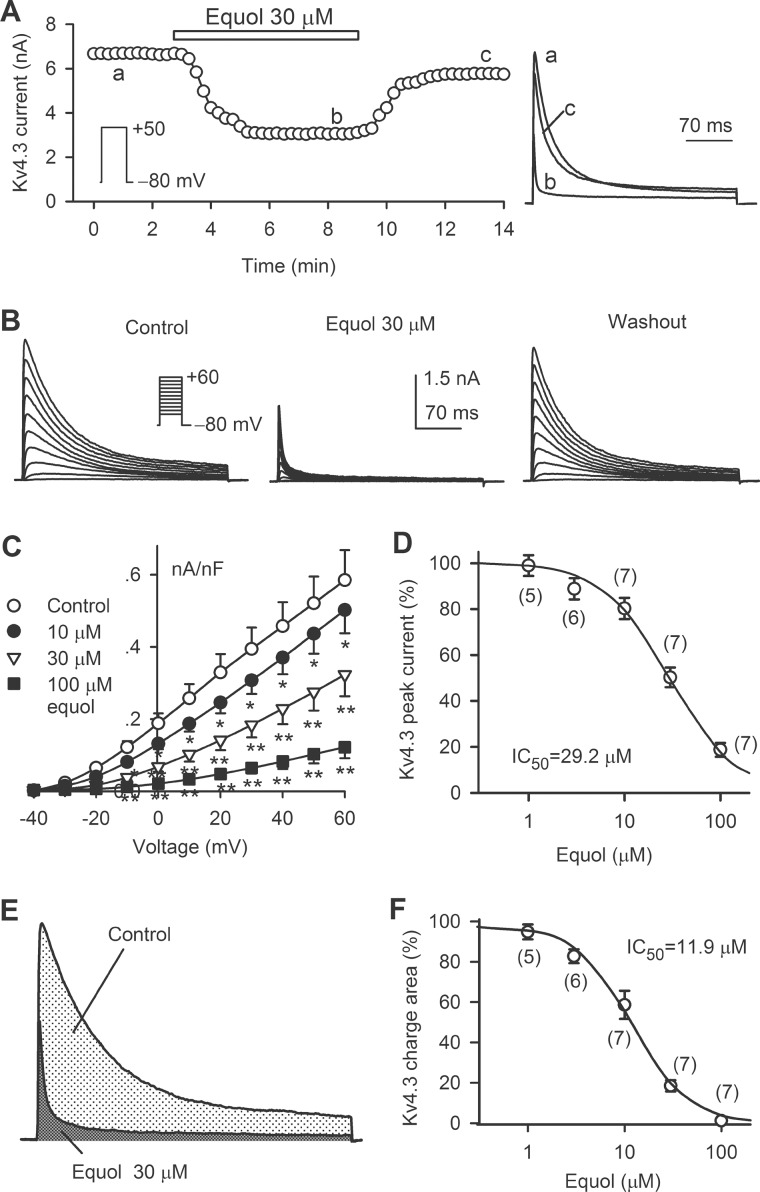
Effect of equol on hKv4.3 current.(A) Time course of hKv4.3 current recorded in a representative HEK 293 cell stably expressing KCND3 with the voltage protocol shown in the inset in the absence and presence of 30 μM equol. Original current traces at corresponding time points are shown in the right. (B) Voltage-dependent hKv4.3 current recorded in a typical experiment in the absence and presence of 30 μM equol and upon washout. (C) I-V relationships of hKv4.3 current in the absence and presence of 10, 30 and 100 μM equol (n = 7, *P<0.05, **P<0.01 vs. control). (D) Concentration-response relationship for inhibiting hKv4.3 current by equol at +50 mV. The numbers in the parentheses represent experimental number. (E) Representative hKv4.3 traces for integrating area under current curves in the absence and presence of 30 μM equol. (F) Concentration-response relationship of hKv4.3 charge area reduction by equol at +50 mV was fitted to the Hill coefficient. The numbers in the parentheses represent experimental number.